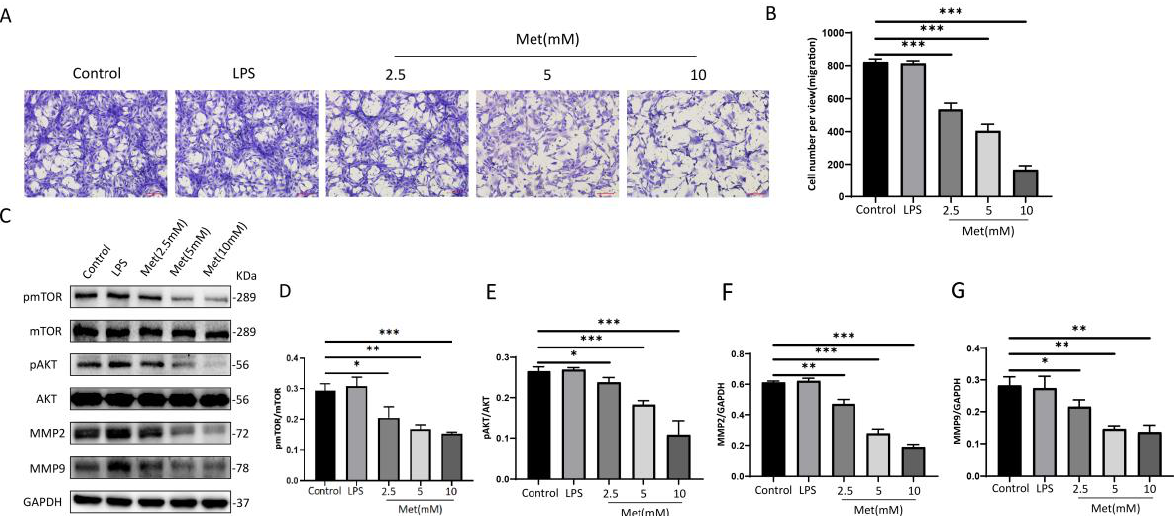
Figure 4. Metformin inhibits NIH 3T3 cell migration by activating AMPK/mTOR in a concentration−dependent manner . ( A , B ) NIH 3T3 cells in the upper chamber were incubated in the presence of different concentrations of metformin (2.5 mM, 5 mM, 10 mM) for 24 h and the number of migrating cells was observed in five random fields under a 100× microscope. Scale bar = 100 μm . Cell migration was quantified using ImageJ/Fiji software. Values represent the means ± SEs of the numbers of migrating cells from three independent experiments. ( C − G ) Relative band densities of pmTOR/mTOR, pAKT/AKT, MMP2, and MMP9 are quantified in the bar graphs. All the experiments were performed in triplicate and repeated on at least three occasions. Data are shown as means ± SDs. * p < 0.05, ** p < 0.01, and *** p < 0.001. Control: NIH 3T3 cells, LPS: NIH 3T3 cells treated with 1 μg /mL LPS for 24 h, Met (2.5 mM): NIH 3T3 cells treated with 2.5 mM metformin for 24 h, Met (5 mM): NIH 3T3 cells treated with 5 mM metformin for 24 h, Met (10 mM): NIH 3T3 cells treated with 10 mM metformin for 24 h.